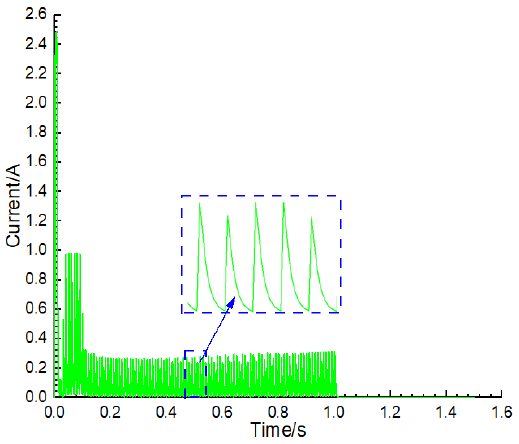
Figure 14. Current curve of No.1 valve.